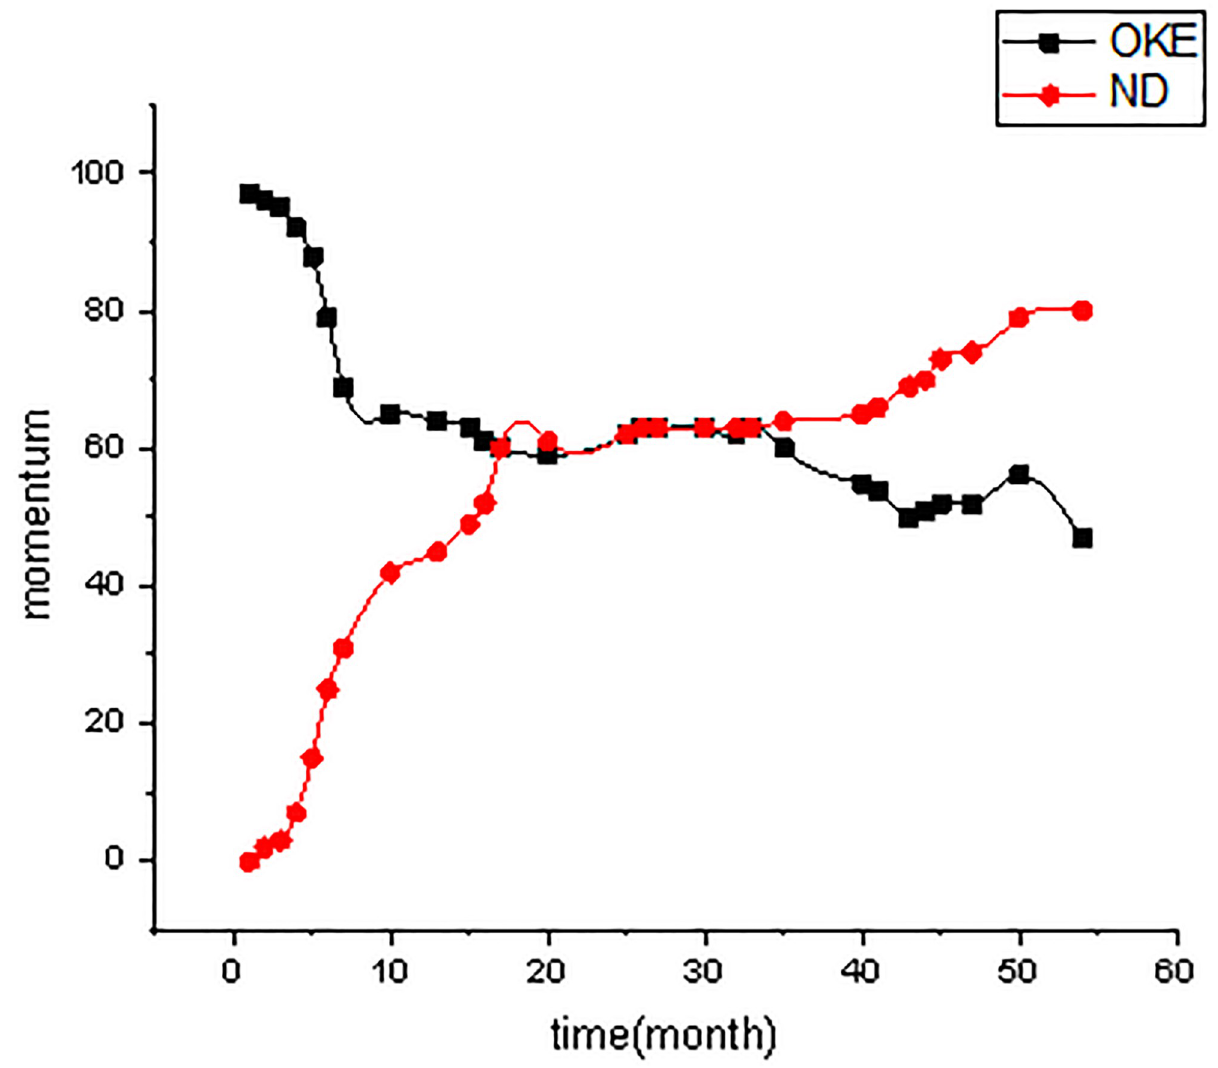
Fig 2. Change of green transformation momentum in manufacturing industry at different